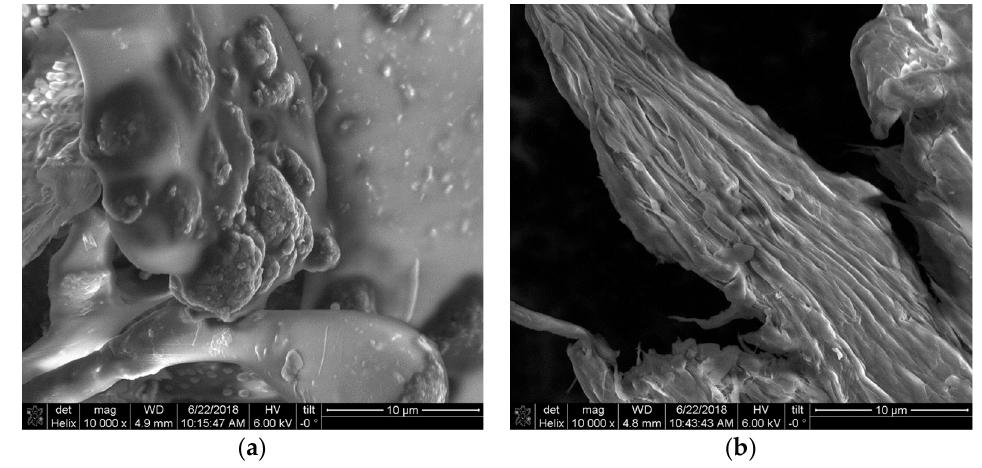
Figure 3. SEM pictures of nanohybrid C@HSA-MNPs@rGO.